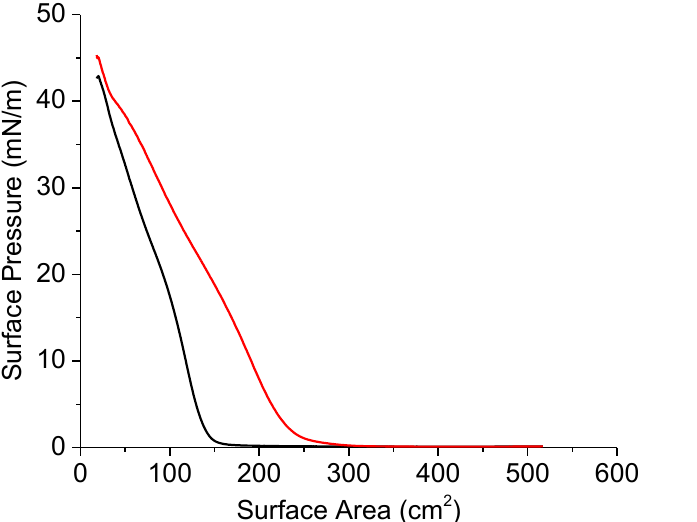
Figure 2. Compression isotherms of a lysozyme layer 1 h after spreading (black line) and at 1 h after spreading and a DNA injection (red line). The total DNA concentration is 50 μM.